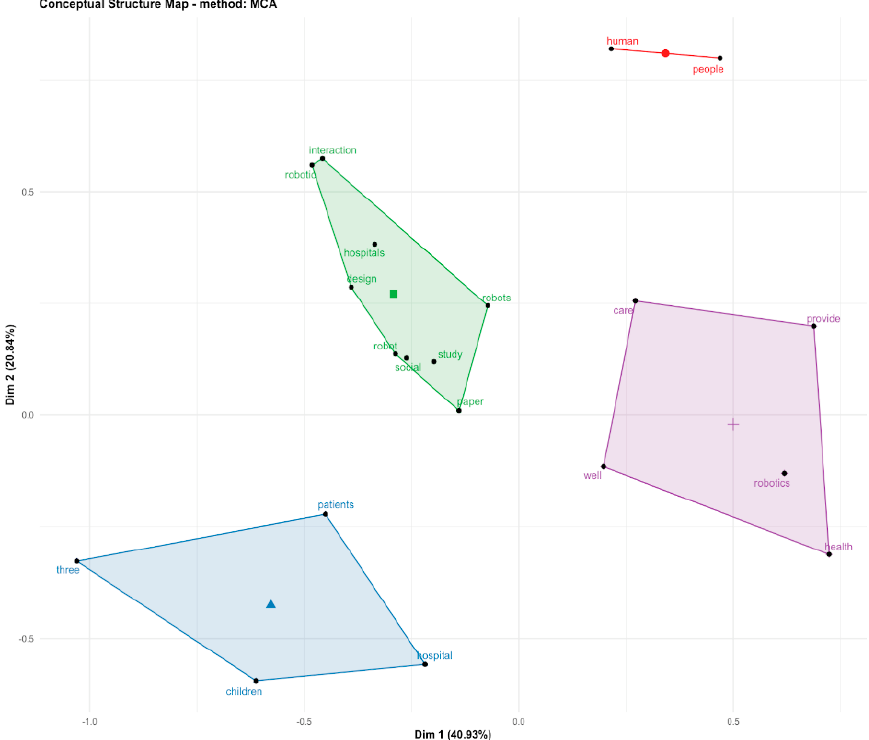
Figure 6. Factorial analysis corresponding to Multiple Correspondence Analysis (MCA). Four stable factors were found. Table 3. Research question 1 (RQ1) on design approaches and main